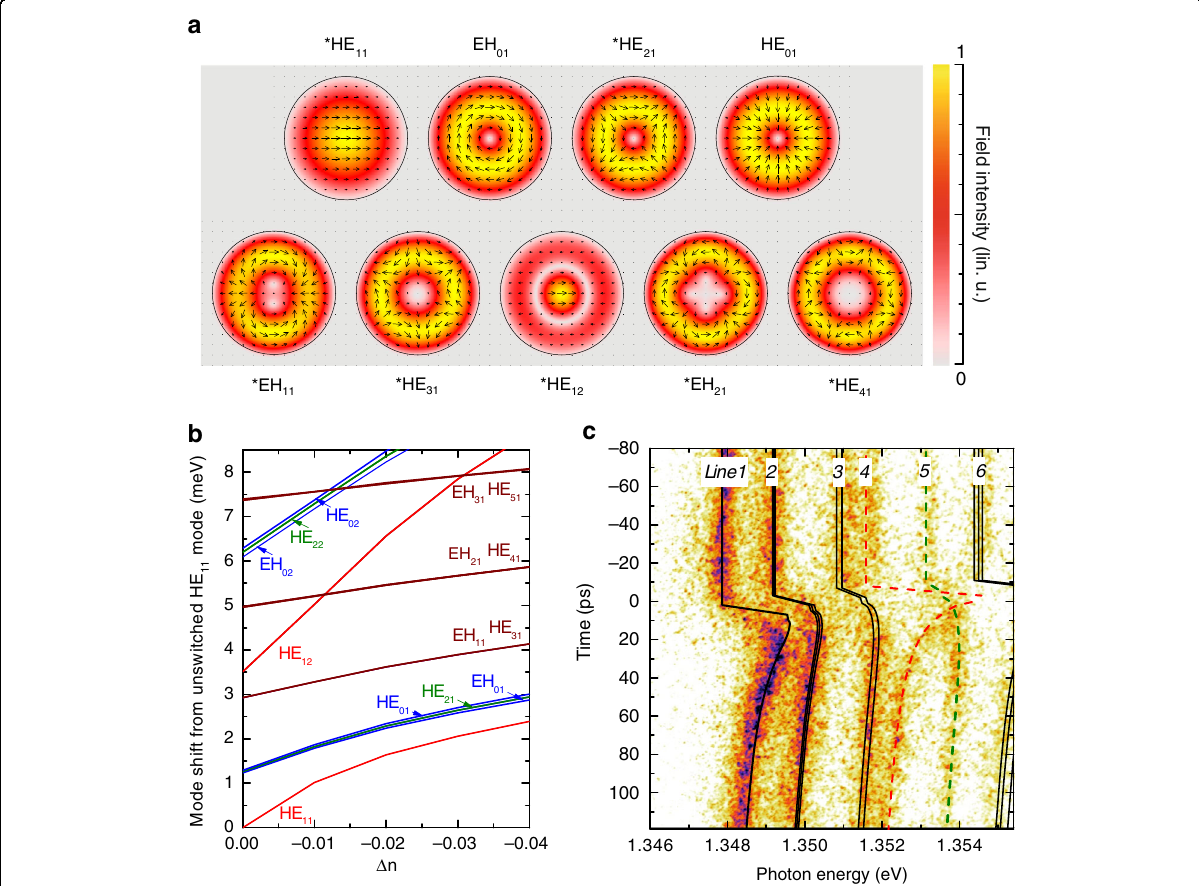
Fig. 2 Mode crossings induced by on-axis free carrier injection. a Vectorial maps of the in-plane electric fi eld and color maps of the fi eld intensity for the con fi ned modes which contribute to Lines 1 – 5 in a 6 µm diameter unswitched QDM (Line 1: HE 11 ; Line 2: HE 01 , HE 21 , EH 01 ; Line 3: HE 31 , EH 11 ; Line 4: HE 12 ; Line 5: HE 41 and EH 21 ). A black line marks the edge of the QDM and the linear color scale is normalized at the antinode for each mode. For two-fold polarization-degenerate modes, labeled with a star, only one map is shown. b Frequencies of the modes of a 6 µm diameter QDM, after injection of a Gaussian centered distribution of free carriers with 2 µm FWHM, as a function of Δ n , the maximum refractive index change induced in GaAs layers (i.e., on the pillar axis). The frequency of mode HE 11 in the unswitched QDM is used as reference. c Streak camera image obtained on a 6 µm diameter switched QDM excited by a focused centered pump beam. Here, E p = 1.65 eV and P = 20 pJ/pulse. The Gaussian pump beam has a 2 μ m diameter waist. The lines show the calculated mode frequencies, resulting from a model taking into account carrier injection, lateral diffusion, and recombination 48 , assuming a refractive index change Δ n = − 0.02 at beam center in the GaAs cavity layer just after excitation by the pump